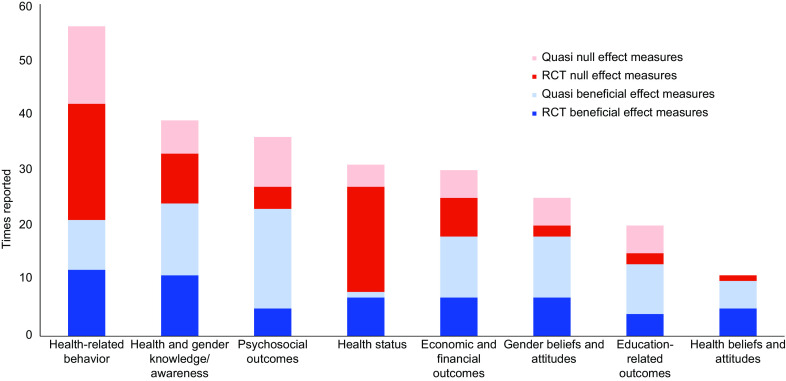
Distribution of Community-Based Girl Group Program Effects by Outcome Domaina,bAbbreviations: Quasi, quasi-experimental; RCT, randomized controlled trial.aBeneficial = Reported statistically significant (α=0.05).bNull = Reported non-significant (α=0.05).